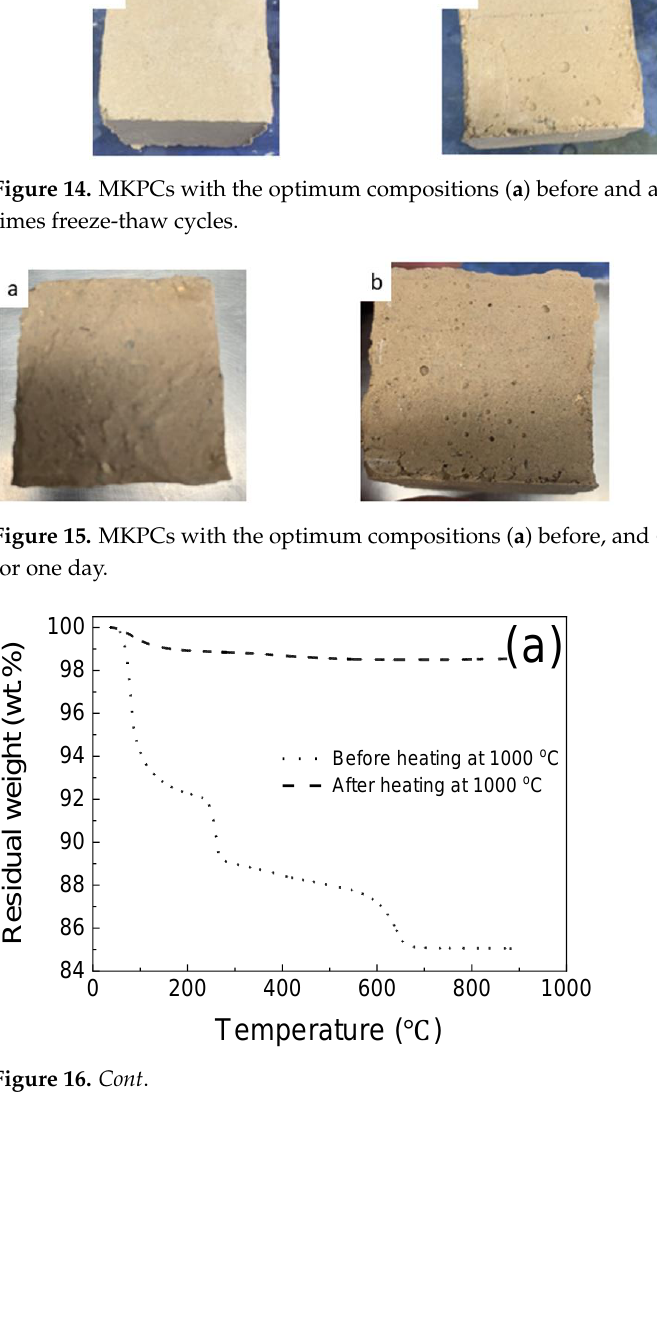
Figure 15. MKPCs with the optimum compositions ( a ) before, and ( b ) after water resistance testing for one day. Figure 14. MKPCs with the optimum compositions ( a ) before and after ( b ) 1, ( c ) 5, ( d ) 10, and ( e ) 15 times freeze-thaw cycles.